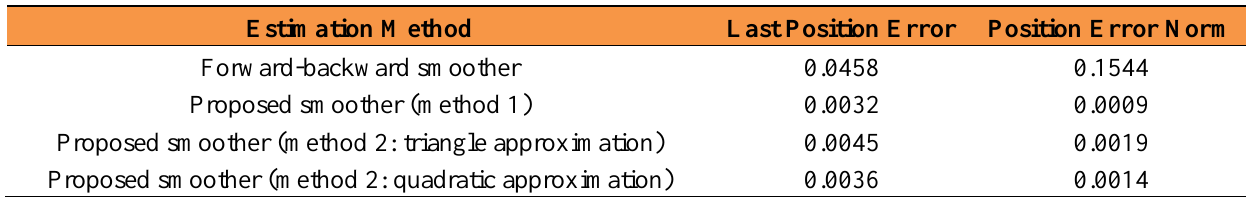
Table 1. Last position accuracy of different